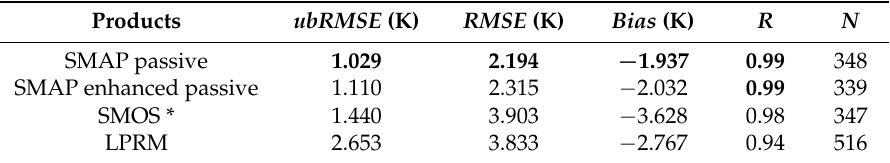
Table 4. Comparison of the SMAP passive (SMAP_P), SMAP enhanced passive (SMAP_P_E), SMOS, and LPRM surface temperature ancillary data, with in-situ measurements, for the REMEDHUS network region. The ubRMSE, RMSE, and bias are in K, R is the correlation coefficient ( p -value < 0.01), and N is the number of samples. Bold data in the table represent the best results concerning each error